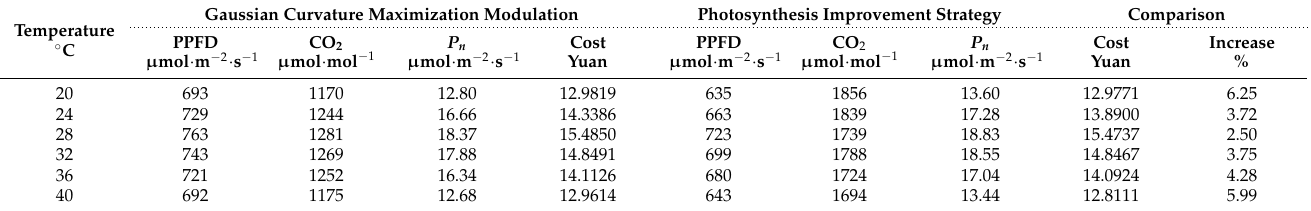
Table 5. Comparison of Gaussian curvature maximization modulation and photosynthesis improve- ment